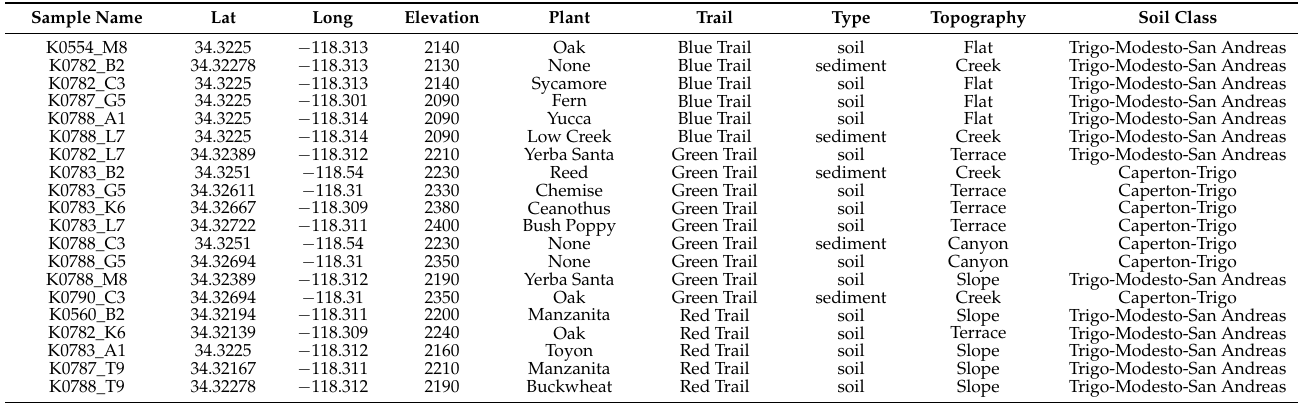
Table 4. Sample metadata from Round 1